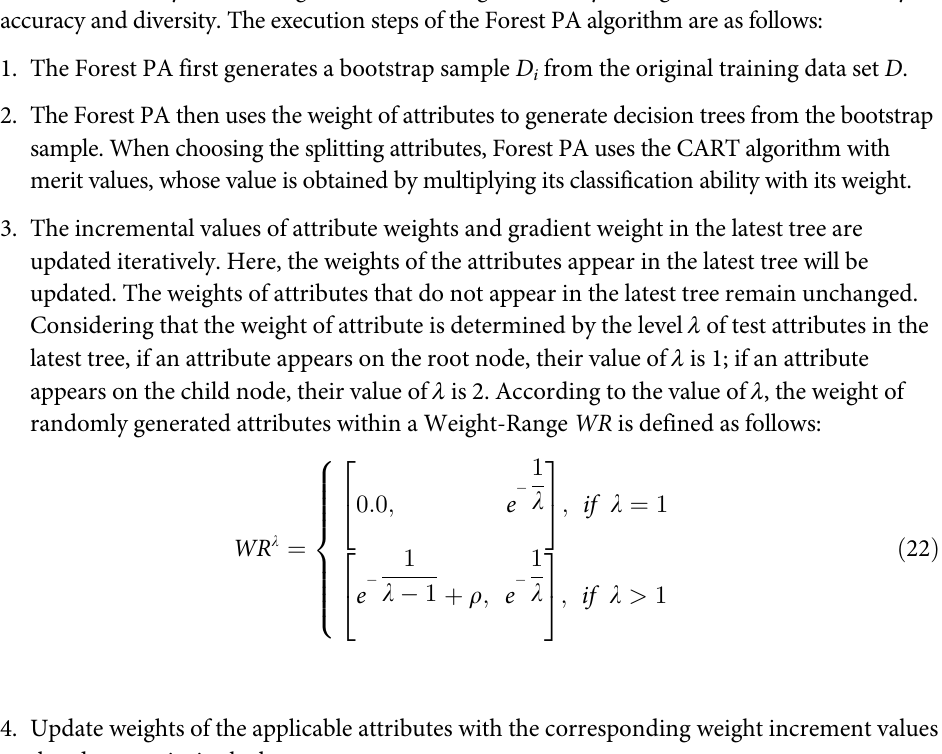
S1 Table. The benchmark dataset contains 739 pairs of positive samples and 739 pairs of negative